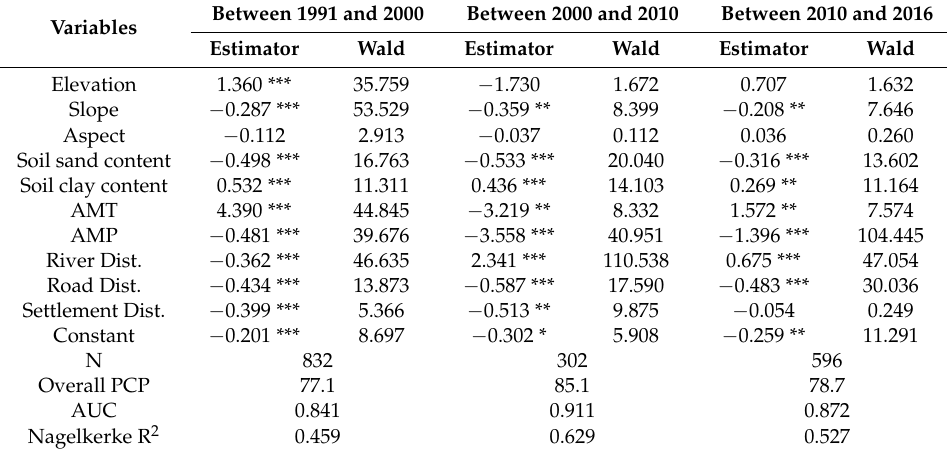
Table 10. Model estimations for the forces driving farmland contractions within DPR Korea TRB region. Between 1991 and 2000 Between 2000 and 2010 Between 2010 and 2016 Variables Estimator Wald Estimator Wald Estimator Elevation